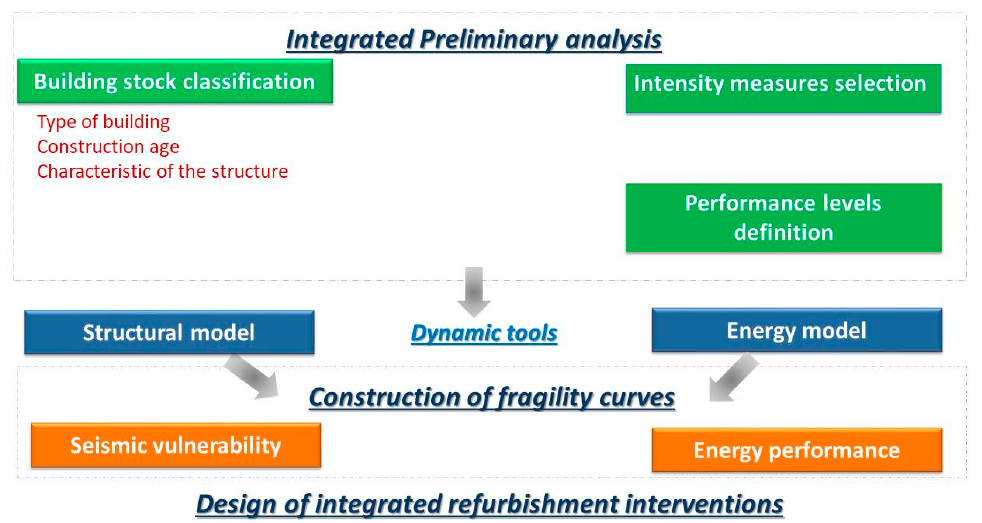
Figure 1. Scheme of the methodological approach.